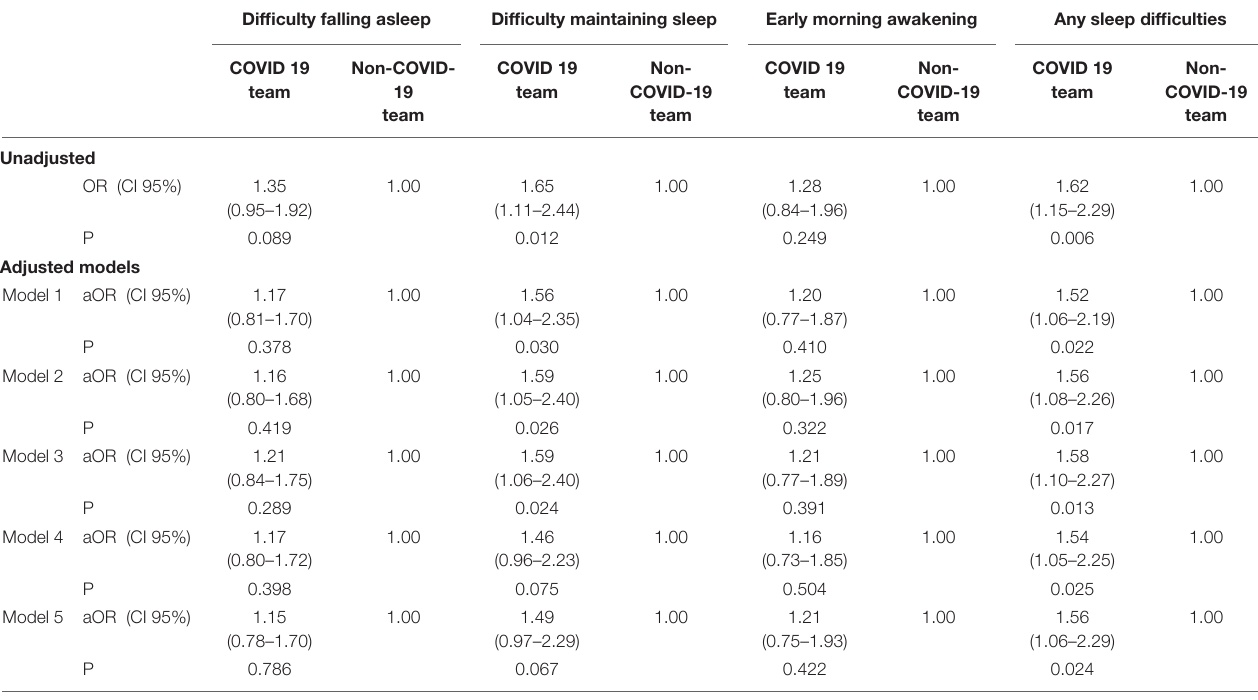
TABLE 2 | Crude and adjusted odds ratios for sleep difficulties among COVID-19 vs. non- COVID-19 teams. Difficulty falling asleep Difficulty maintaining sleep Early morning